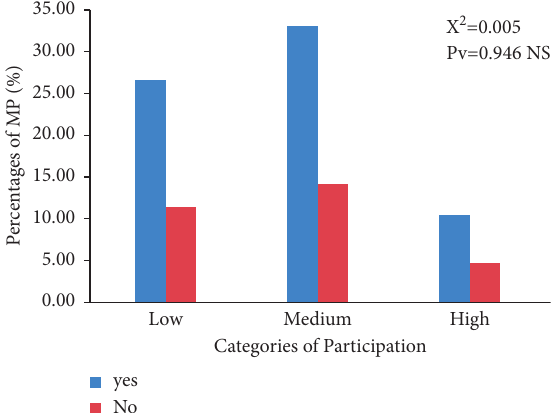
Figure 5: Relationship between saving and credit accessibility and member participation. Note: NS